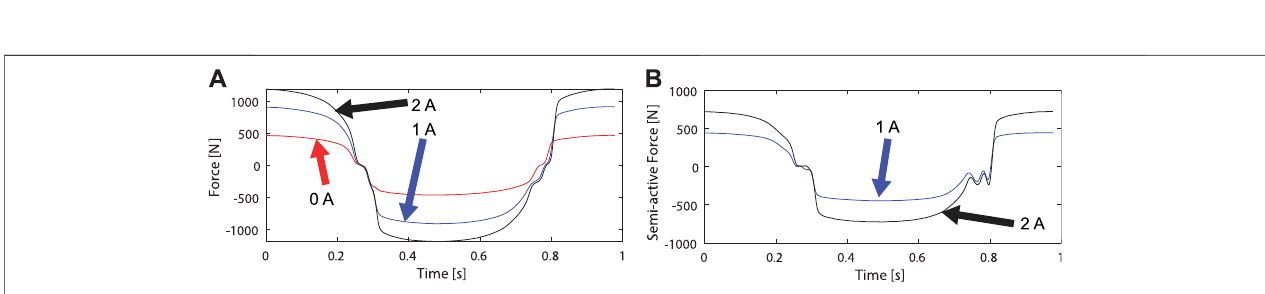
FIGURE 14 | FV Characteristic diagrams for a 2 Degrees of Freedom MR shock absorber for the three cases of electric current (0, 1 and 2 A) and pressure (0, 20 and 40 bar). The fi rst upper row shows the three FV diagrams for the different amplitudes. The second row shows a FV diagram, where it is emphasized the effects of pressure and electric current on the damping force, and how it changes according to the velocity amplitude.